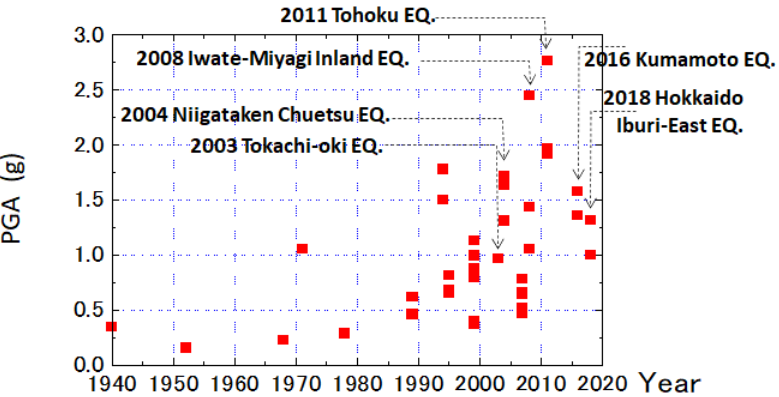
Figure 1. PGAs observed during strong earthquakes in recent years mainly in Japan.